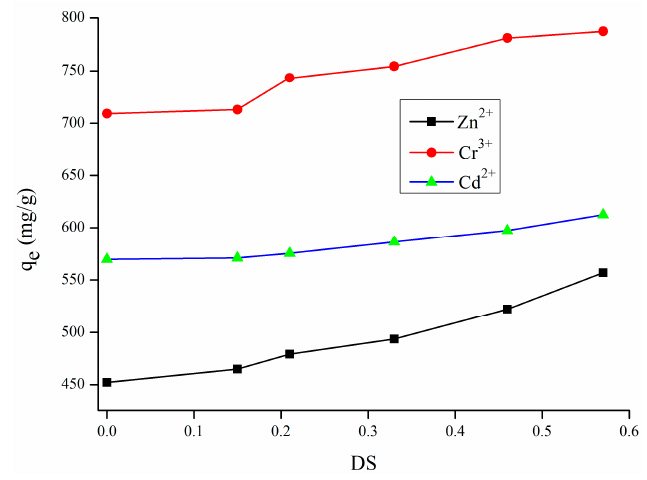
Figure 6. Effect of DS on the hydrogel adsorption for xylan-chain-g-acrylic acid (CAX-g-AA) hydrogel.